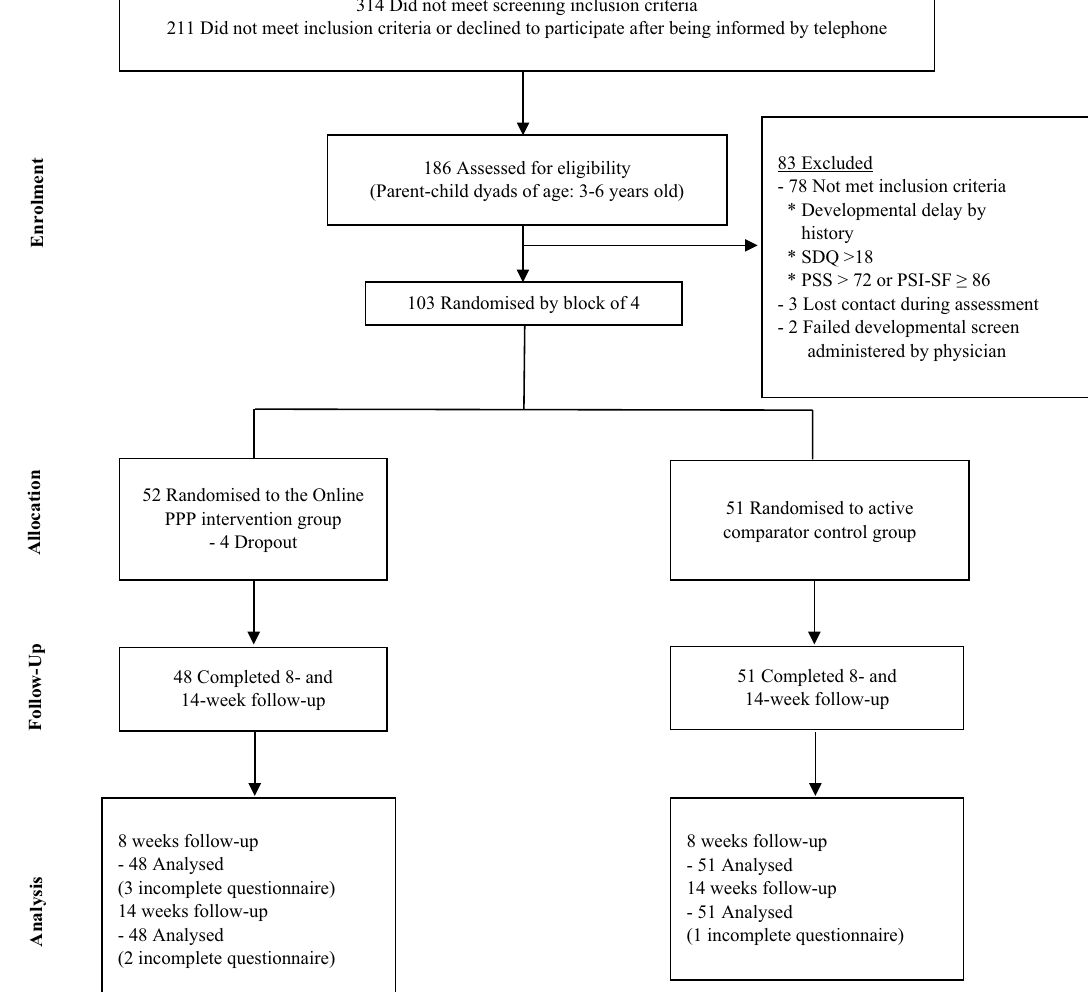
Figure 1. Participant flow diagram of randomised controlled trial with intention-to-treat